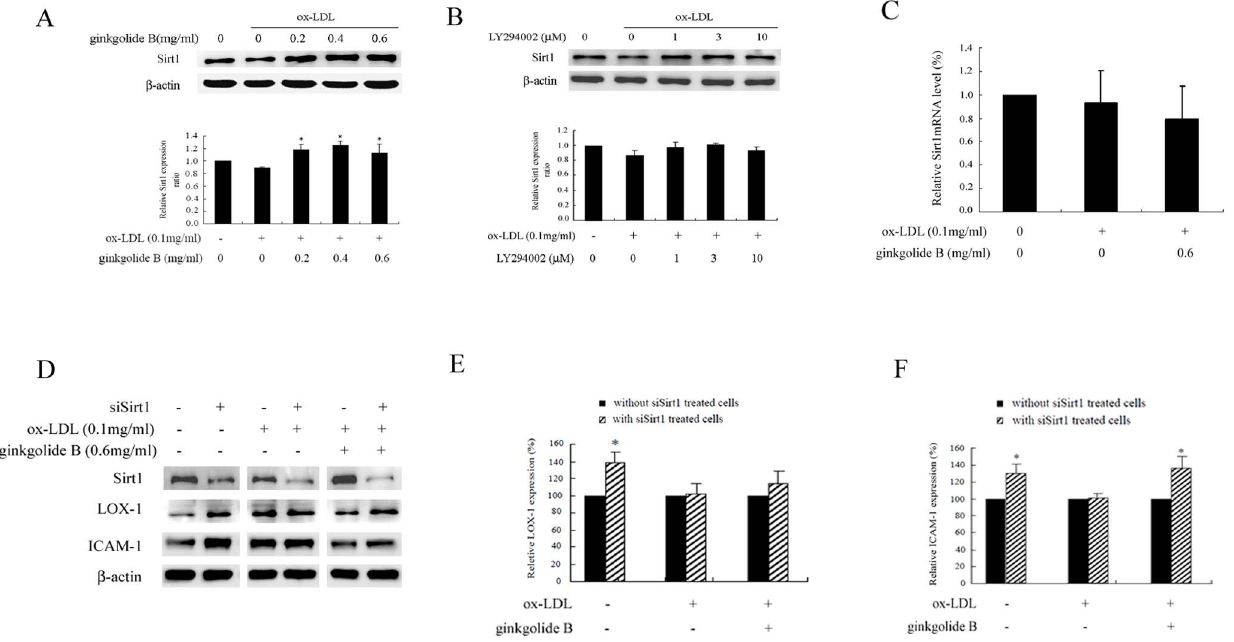
Figure 6. Ginkgolide B increases Sirt1 expression in ox-LDL-stimulated endothelial cells. (A) Ginkgolide B increased Sirt1 expression. # p , 0.05, compared with control; * p , 0.05, compared with ox-LDL-stimulated cells. (B) LY294002 had no effect on Sirt1 expression. (C) Quantitative analysis of the level of Sirt2 mRNA by RT-PCR. GADPH was used as an internal reference in the reactive system. (D) Sirt1 siRNA increased LOX-1 and ICAM-1 expression. (E) Analysis of LOX-1 expression in Sirt1 siRNA-transfected cells. * p , 0.05, difference between Sirt1 siRNA-transfected and - nontransfected cells. (F) Analysis of ICAM-1 expression in Sirt1 siRNA-transfected cells. * p , 0.05, difference between Sirt1 siRNA-transfected and - nontransfected cells. The data were obtained from three independent